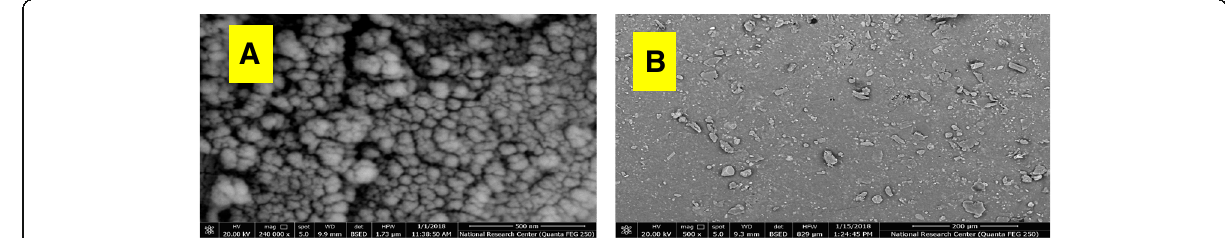
Fig. 2 SEM micrographs of a microalgal biomass and b bioplastic